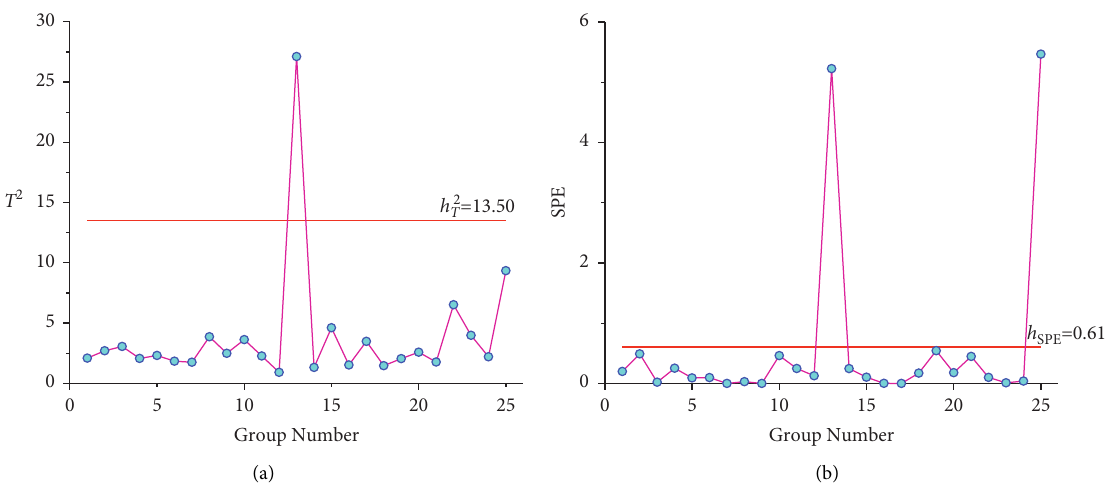
Figure 3: T 2 control chart and SPE control chart of catenary in abnormal states. (a) Principal component T 2 control chart; (b) SPE control